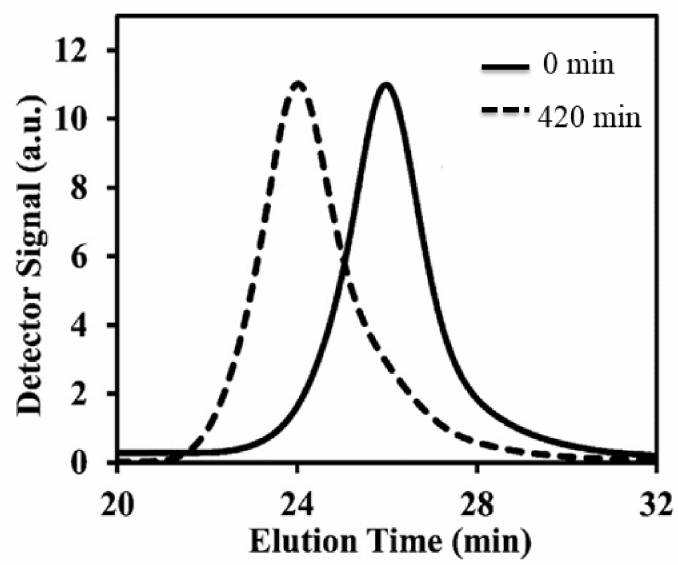
Figure 2. GPC traces of polymyrcene and its copolymer with styrene, synthesized via nitroxide-mediated radical polymerization. (Reproduced from Reference 39, with permission from American Chemical